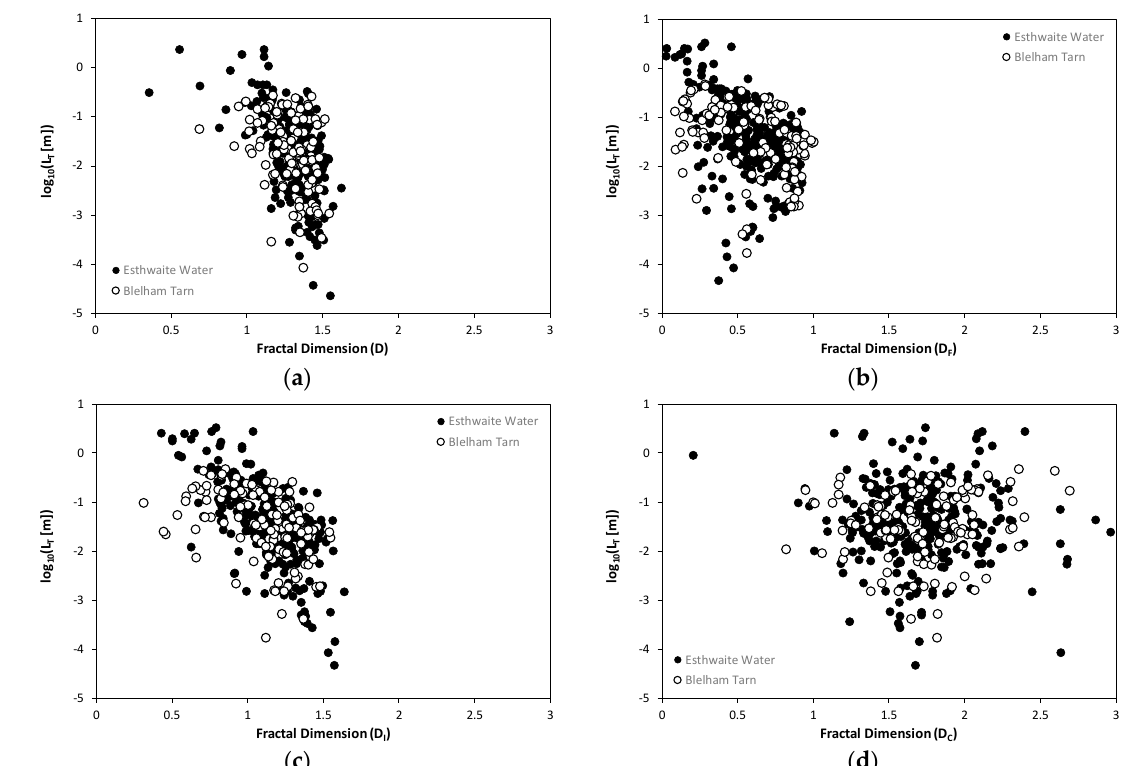
Figure 11. Plots of log 10 (L T ) against ( a ) D; ( b ) D F ; ( c ) D I ; and ( d ) D C . Data from all depths bins, all profiles and all dates combined.